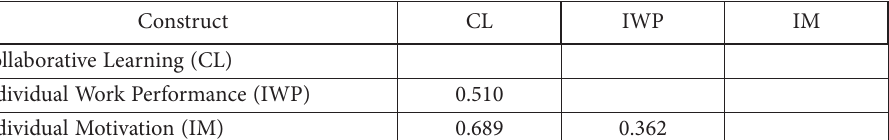
Table 5. The Heterotrait–Monotrait (HTMT) ratio of correlations